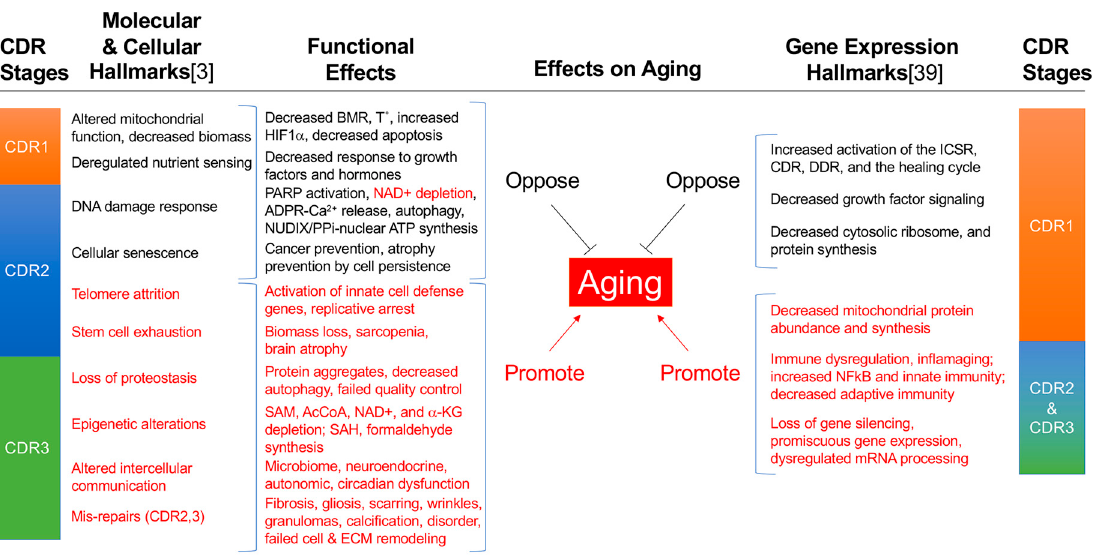
Figure 3. The hallmarks of aging as natural products of incomplete healing and the cell danger response [3,39]. Black font: hallmarks that oppose aging. Red font: hallmarks that promote aging. Abbreviations: CDR—cell danger response, ICSR—integrated cell stress response, DDR—DNA damage response, BMR—basal metabolic rate, T ◦ —basal body temperature, HIF1 α —hypoxia inducible factor 1 α